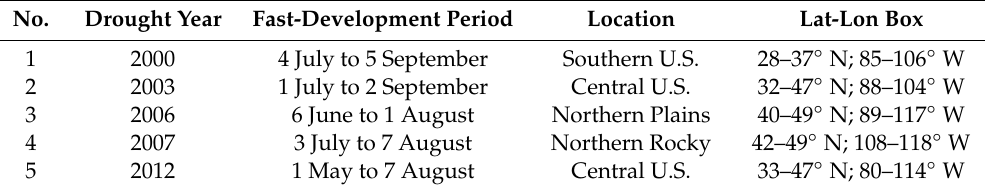
Table 1. Location and time period of five selected flash droughts used in this